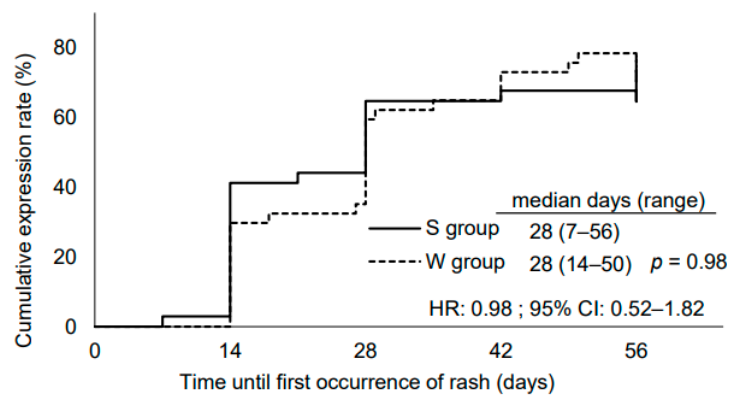
Figure 4. Distribution of time until the first incidence of rash. HR, hazard ratio; CI, confidence in- terval.